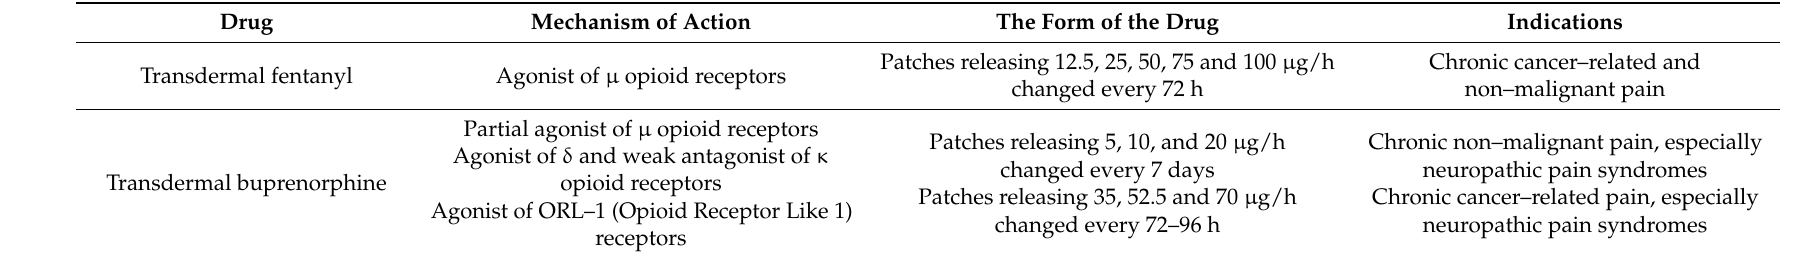
Table 1. Transdermal application of opioid